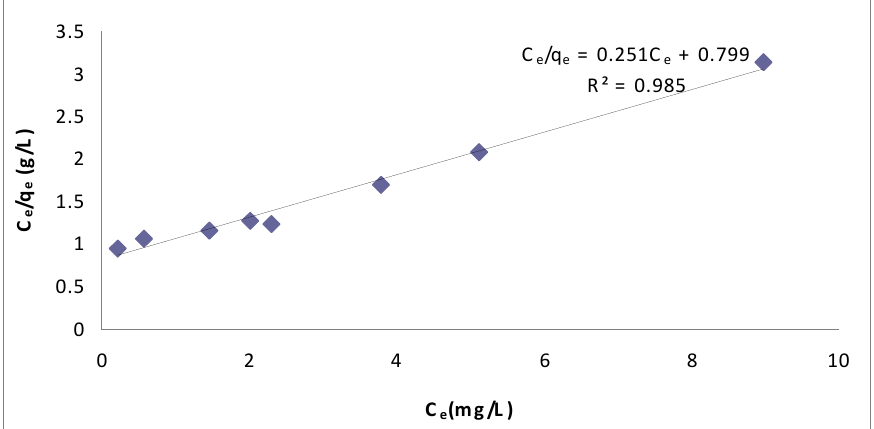
Figure 9. Langmuir plot for adsorption of 2,4-dinitrophenol by MIP.